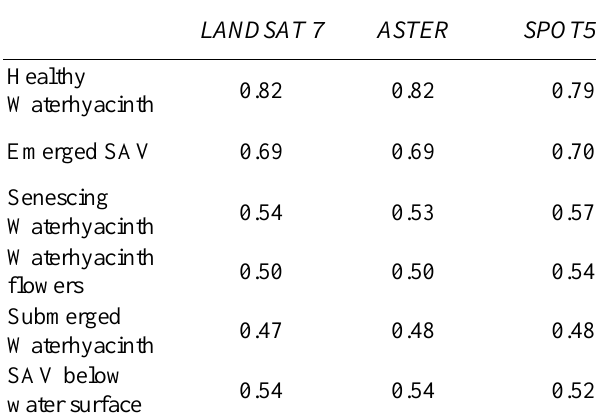
Table 2 : Mean NDVI (Normalized Difference Vegetation Index) values calculated from the reflectance values integrated to match the red and near infrared bands of the three satellite